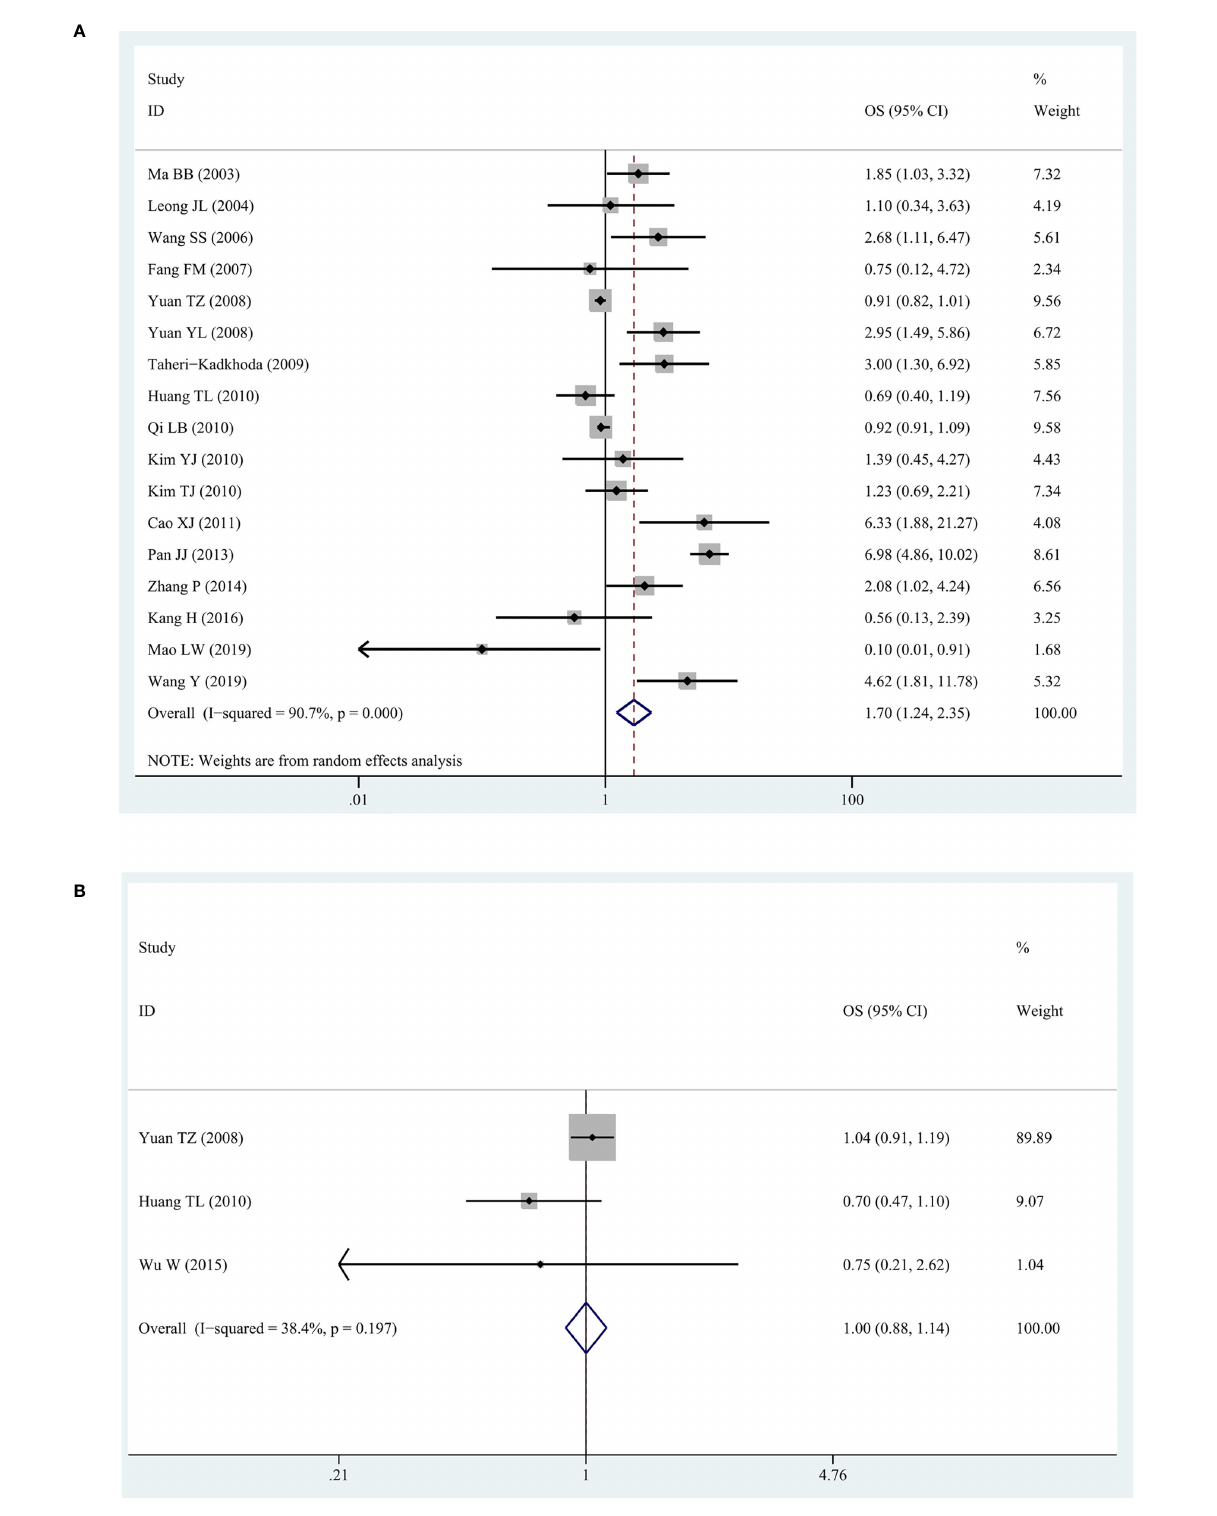
FIGURE 2 | The forest map for relationship between EGFR/p-EGFR and OS in NPC. (A) EGFR and OS. (B) p-EGFR and